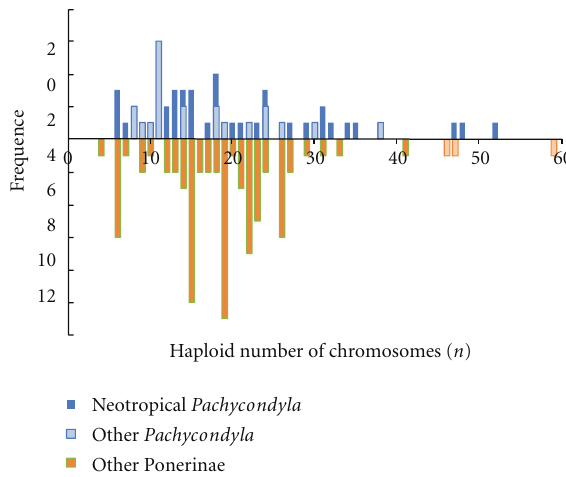
Figure 2: Distribution and frequency of haploid chromosome numbers in the Ponerinae subfamily, up to the X -axis: Pachycondyla spp.; down to the X -axis: other Ponerinae. The bars in lighter color in the range of “other Ponerinae” represent the known karyotypes in the Dinoponera genus (ref: as in Table 1 for Neotropical Pachycondyla spp.; for the others (genera Anochetus , Centromyrmex , Cryptopone , Diacamma , Dinoponera , Hypoponera , Leptogenys , Odontomachus , Odontoponera , Platythyrea , Ponera ): [19, 36, 37, 39], Hypoponera spp.: n = 6, 19; Leptogenys spp.: n = 15, 21; Platythyrea spp.: n = 20, 22; Thaumatomyrmex spp.: n = 10, 21, 31 [Mariano et al., unpublished